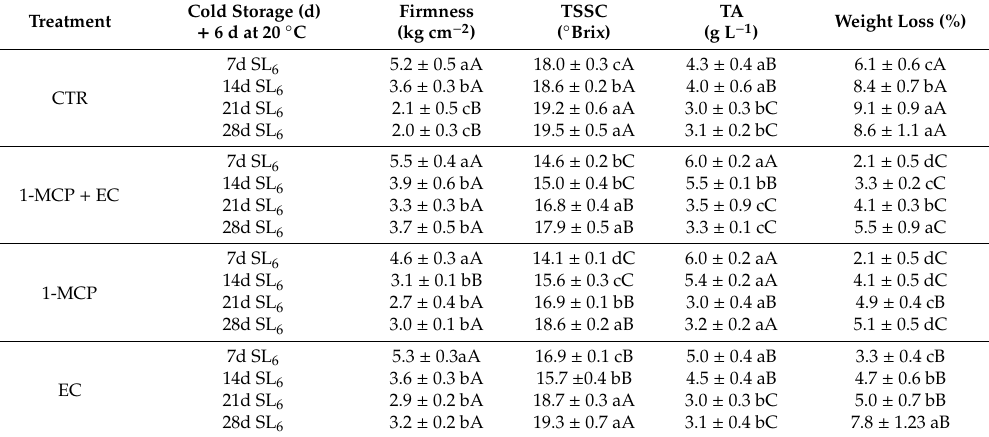
Table 1. Evolution of firmness (kg cm − 2 ), total soluble solid content (TSSC), and total titratable acidity (TA), in white flesh melting peaches, cv Settembrina , during shelf life at 20 ◦ C (SL6) at six days after cold storage (7, 14, 21, 28